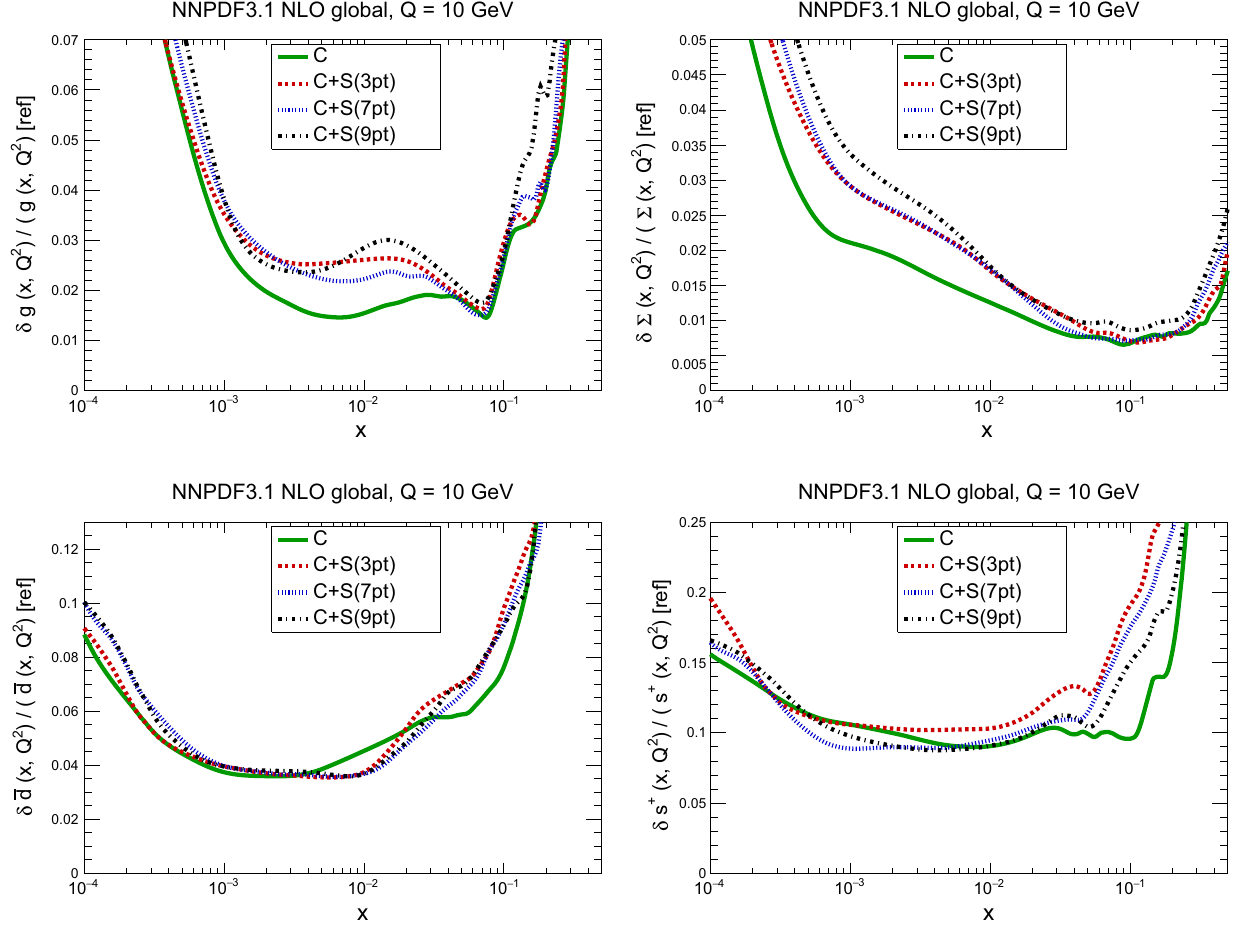
Fig. 19 Same as Fig. 18, now showing relative PDF uncertainties, normalized to the central value of the baseline set. Note that the y -axes ranges are different for each PDF combination so, the NLO uncertainty band does not contain the NNLO central value, which lies just above the edge of the